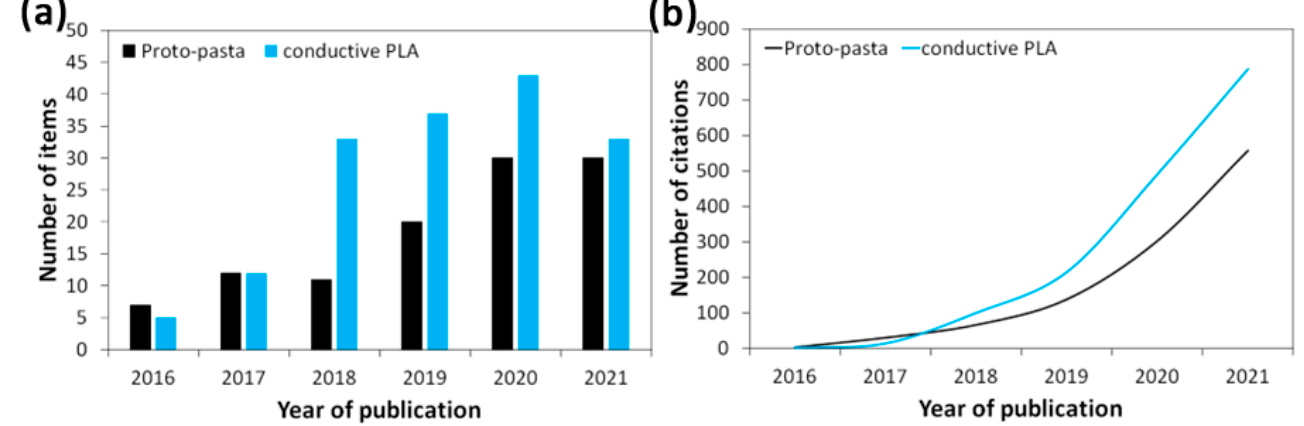
Figure 1. Trend of ( a ) number of scientific papers published; and ( b ) citation of works related to conductive PLA composites. Search was performed in the category “All Fields” in the period 2016–2021, considering the keywords “Proto-pasta” (the most popular conductive filament) and “conductive PLA”. Presented data were collected from the Scopus ® database on 05 October 2022.